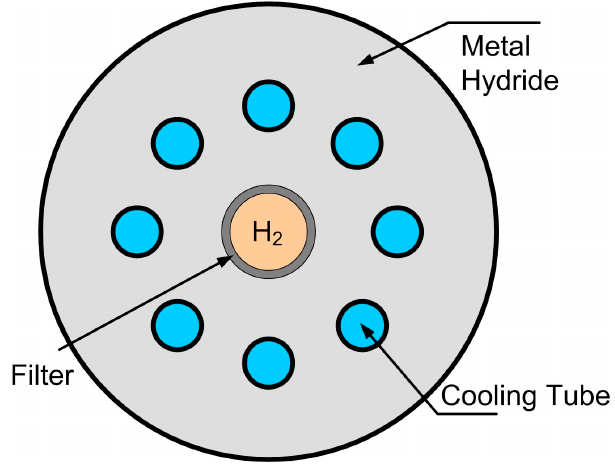
Figure 3. Cross-section of an annulus reactor .